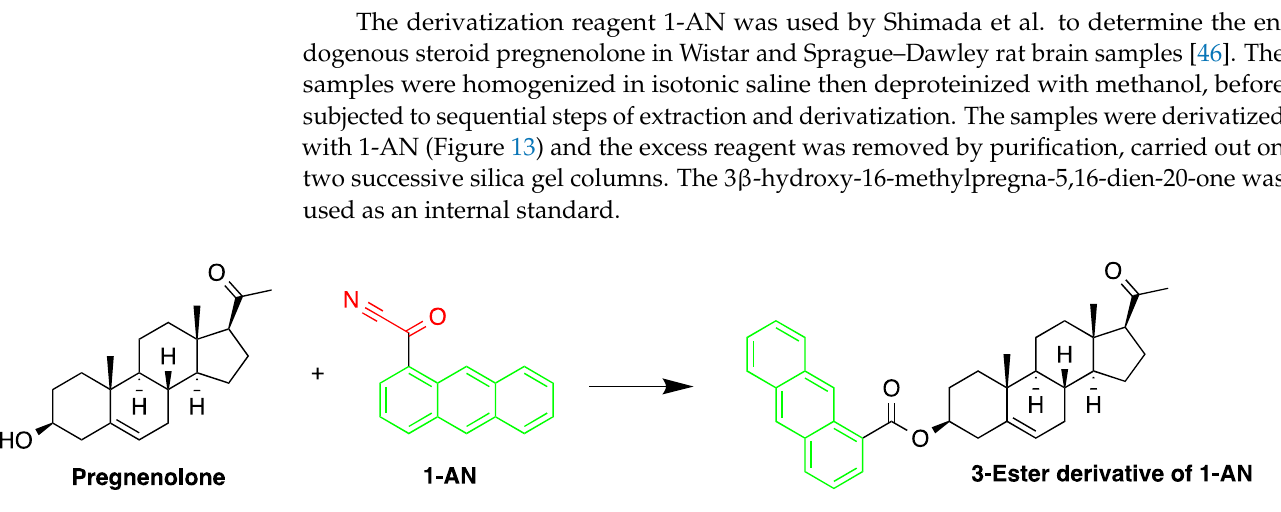
Figure 13. Derivatization of pregnenolone by 1-anthroyl nitrile (1-AN).